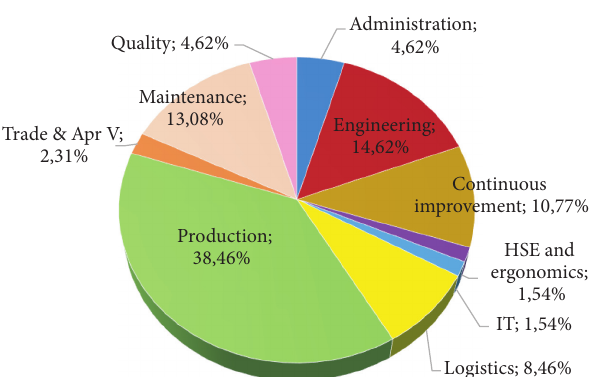
Figure 8: The services of the participating organizations.